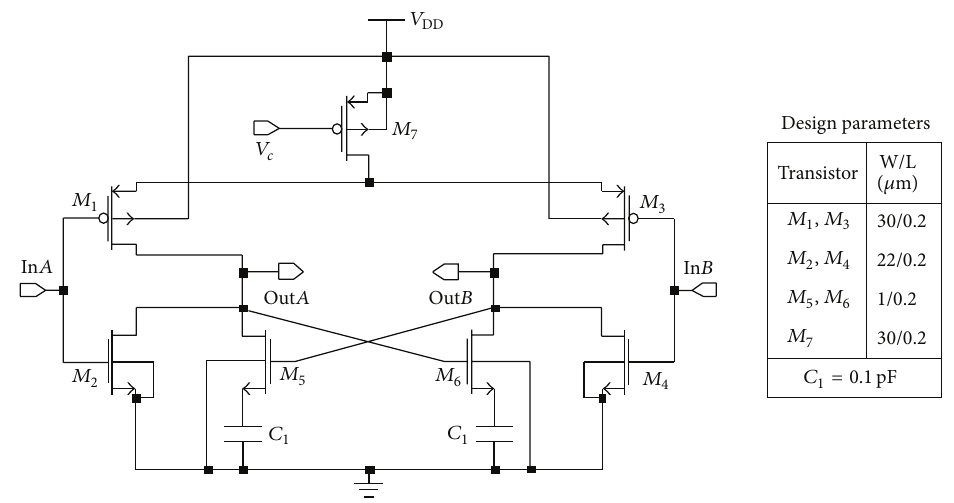
Figure 3: Schematic diagram of the proposed delay